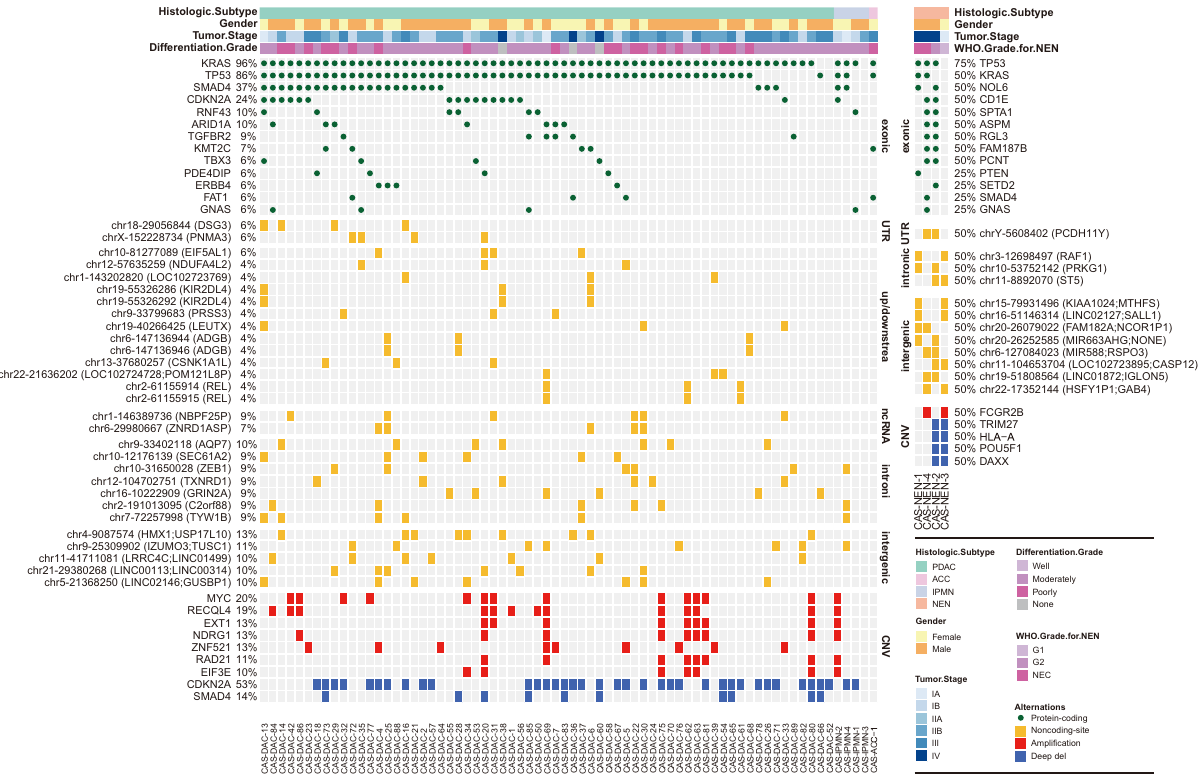
Fig. 2 WGS analysis of genomic mutations and alterations in PDPCOs. Genomic landscape of 70 exocrine PDPCOs, including PDACs, IPMNs, and ACCs (left), and 4 neuroendocrine PDPCOs (right). The fi gure shows exonic mutations; noncoding mutations in UTR, upstream/downstream, intronic, ncRNA and intergenic regions; and CNVs. CAS-DAC-23 with WES of blood DNA; CAS-NEN-2 without sequencing of blood DNA. PDPCO patient-derived pancreatic cancer organoid, PDAC pancreatic ductal adenocarcinoma, NEN pancreatic neuroendocrine neoplasm, IPMN intraductal papillary mucinous neoplasm, ACC acinar cell carcinoma, CNV copy number